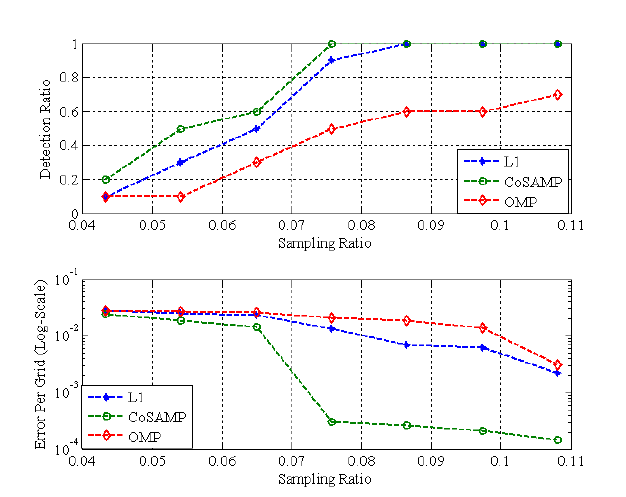
Figure 3. (a) Sampling ratio vs detection ratio (b) sampling ratio vs normalized error per